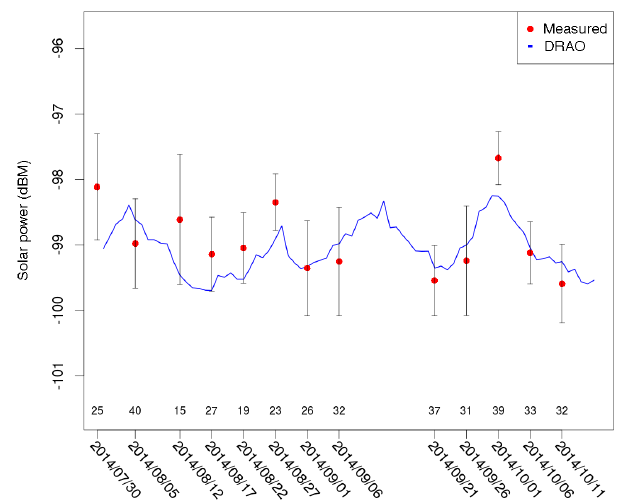
Figure 15. Daily analysis of the solar interferences detected by the Monte Settepani radar during July–October 2014. The value of the power at the top of the atmosphere ( P TOA ) seen by the radar, com- puted from the daily solar interferences, is displayed as red points. The error bars are calculated, for each day, as the square root of the differences between all the measured solar powers and the corre- sponding values computed by the theoretical model. The blue points display the DRAO reference values of the solar power. The amount of the collected solar interferences for each day is shown by the numbers in the plot.